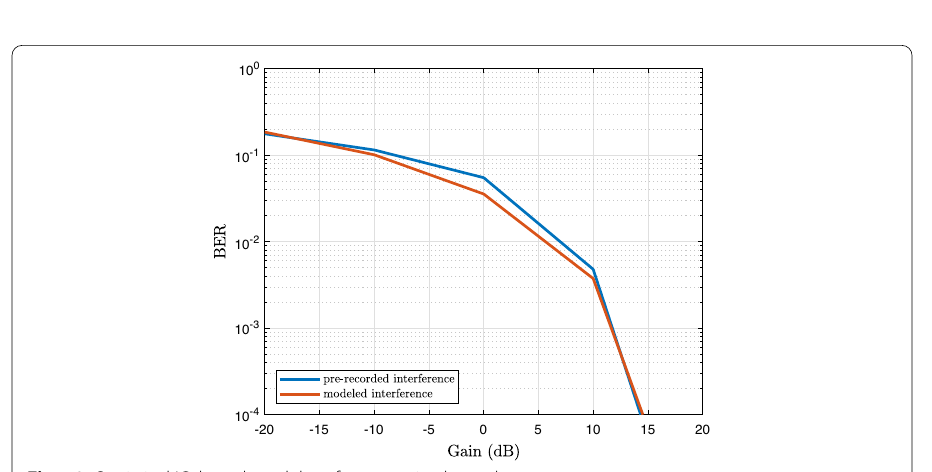
Fig. 13 Statistical IQ-based model performance in channel